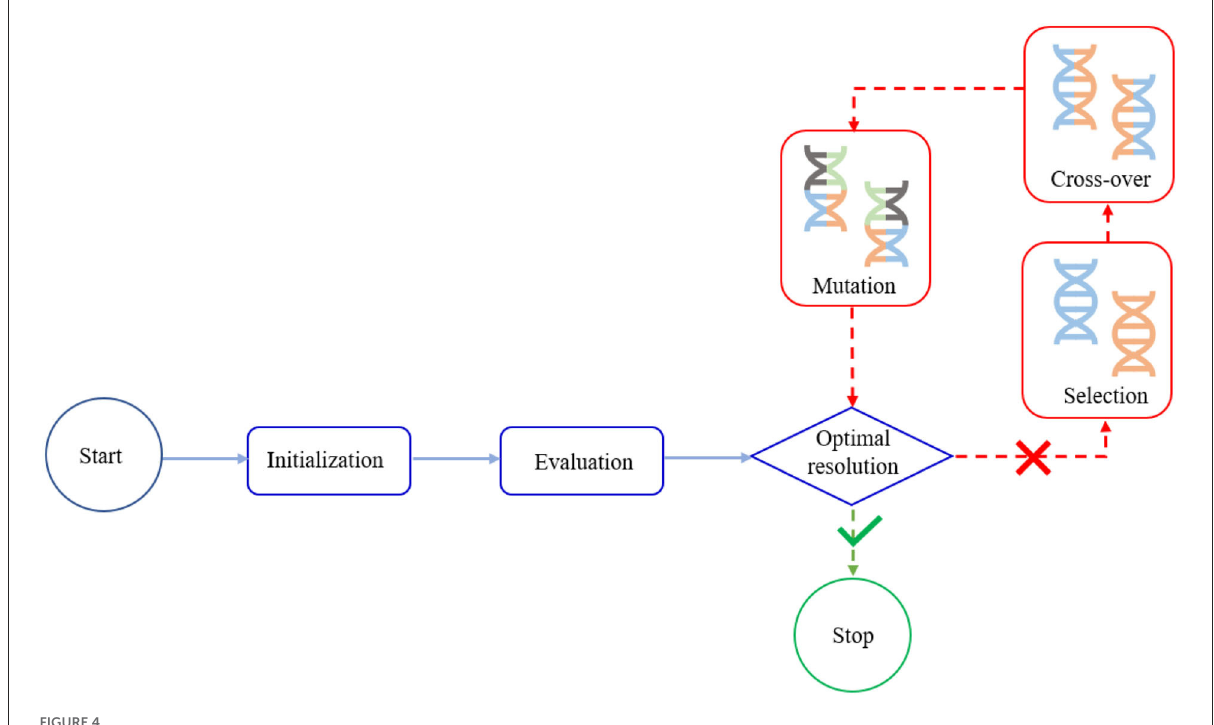
FIGURE4 Genetic algorithm optimization process